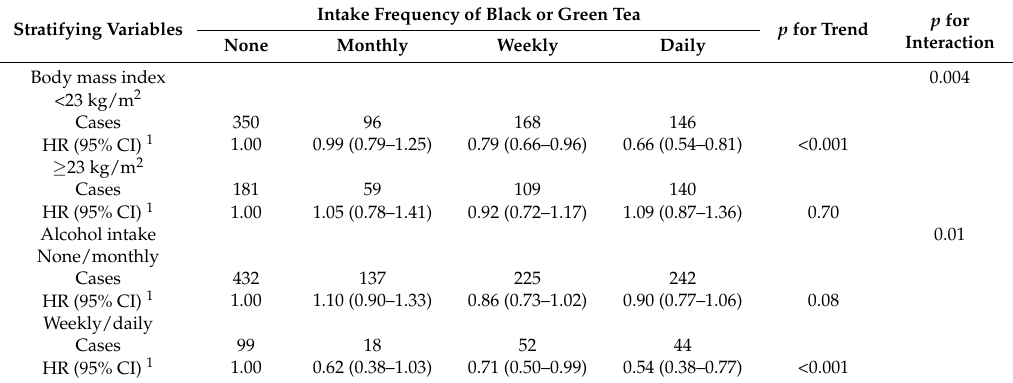
Table 3. Interaction between tea drinking and stratifying variables in relation to risk of